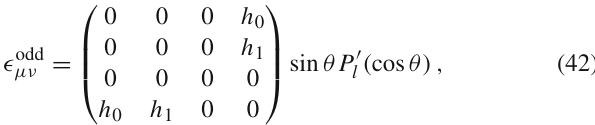
Fig. 1 Existence of the black hole for the DGP branch: The blue part represents the range of the parameters ( ¯ m , ¯ q ) for which the black hole has two horizons. In the gray region, the metric is always negative and the white region corresponds to a black hole with only a cosmological horizon, because of the negativity of the effective mass, hence inside the cosmological horizon the solution would be a naked singularity the crossover scale of the order of the Hubble scale. A